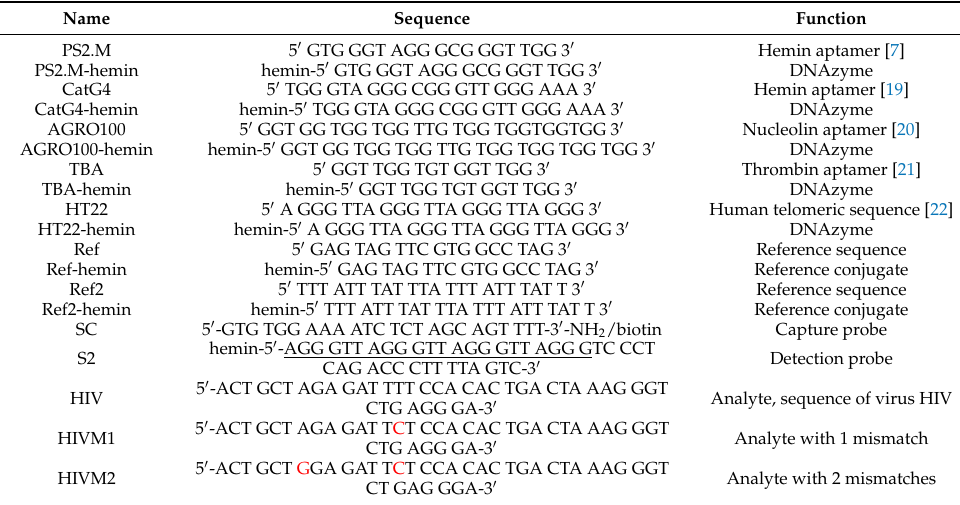
Table 1. Sequences of oligonucleotides used in this